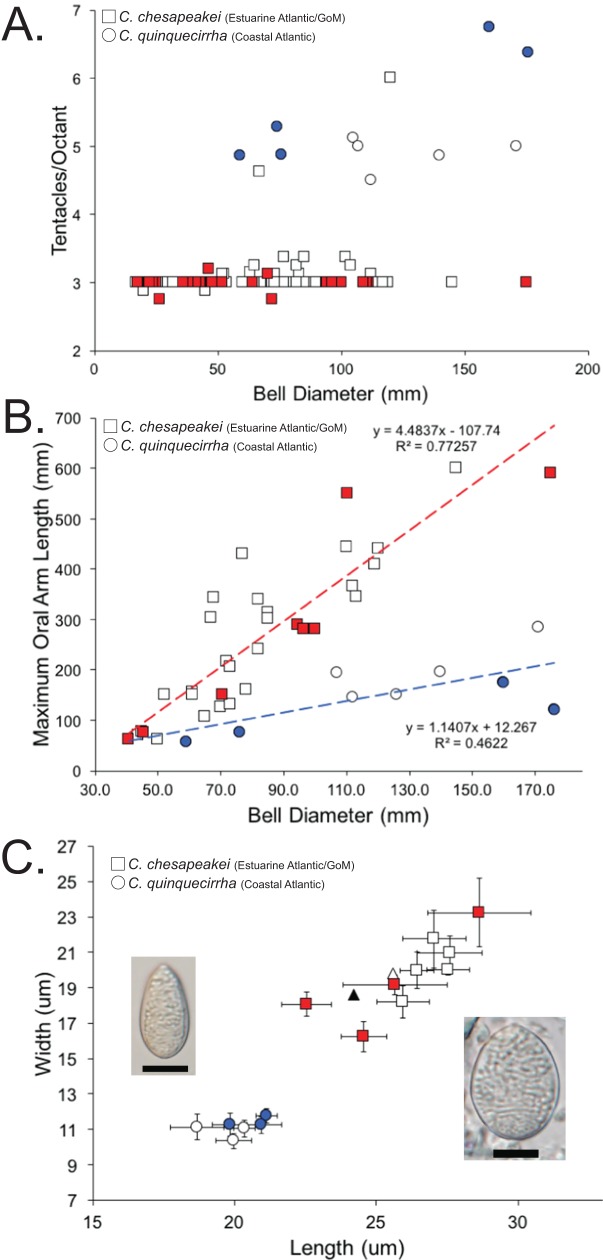
Morphological evidence separating Chrysaora quinquecirrha and Chrysaora chesapeakei.(A) Tentacle counts. Graph represents tentacles per octant against bell diameter (mm) for field collected and museum specimens. Squares represent animals taken from estuarine Atlantic and Gulf of Mexico regions (Chrysaora chesapeakei), while circles represent animals taken from coastal Atlantic regions (Chrysaora quinquecirrha). All animals with 16S sequences matching the Chrysaora chesapeakei clade appear in red, while those whose sequences matched the Chrysaora quinquecirrha clade appear in blue. (B) Maximum oral arm measurements. Graph represents maximum oral arm length against bell diameter (mm) for field-collected and museum specimens. Squares represent animals taken from U.S. Atlantic estuaries and the Gulf of Mexico (Chrysaora chesapeakei), while circles represent animals taken from coastal Atlantic regions (Chrysaora quinquecirrha). Only animals with fully intact and extended oral arms were included. All animals with 16S sequences matching the Chrysaora chesapeakei clade appear in red, while those whose sequences matched the Chrysaora quinquecirrha clade appear in blue. (C) Average size measurements for holotrichous A-isrohiza nematocysts (length vs. width), based on 10 nematocysts per. Error bars represent 95% CI (2*standard error). Squares represent nematocysts from estuarine Atlantic and Gulf of Mexico medusae (Chrysaora chesapeakei), while circles represent nematocysts from coastal Atlantic medusae (Chrysaora quinquecirrha). Photograph of an average sized A-isorhiza from Chrysaora quinquecirrha appears on the left and a photograph of an average size A-isorhiza from Chrysaora chesapeakei appears on the right. Scale bars = 10 μm. Photographs have been resized so that all error bars are the same size on the page to allow size comparisons. All animals with 16S sequences matching the Chrysaora chesapeakei clade appear in red, while those whose sequences matched the Chrysaora quinquecirrha clade appear in blue. Triangles represent average values from Papenfuss (1936) for morphs identified as Dactylometra quinquecirrha (gray) or Dactylometra quinquecirrha var. chesapeakei (white).